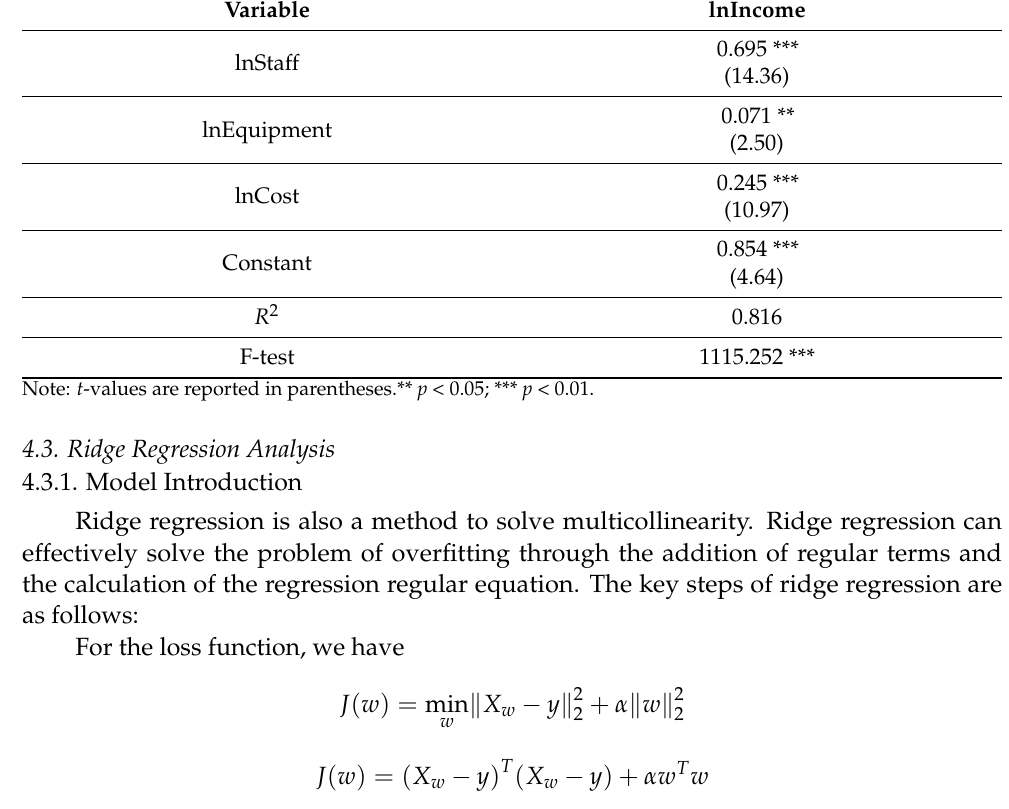
Table 6. Lasso regression results. Variable